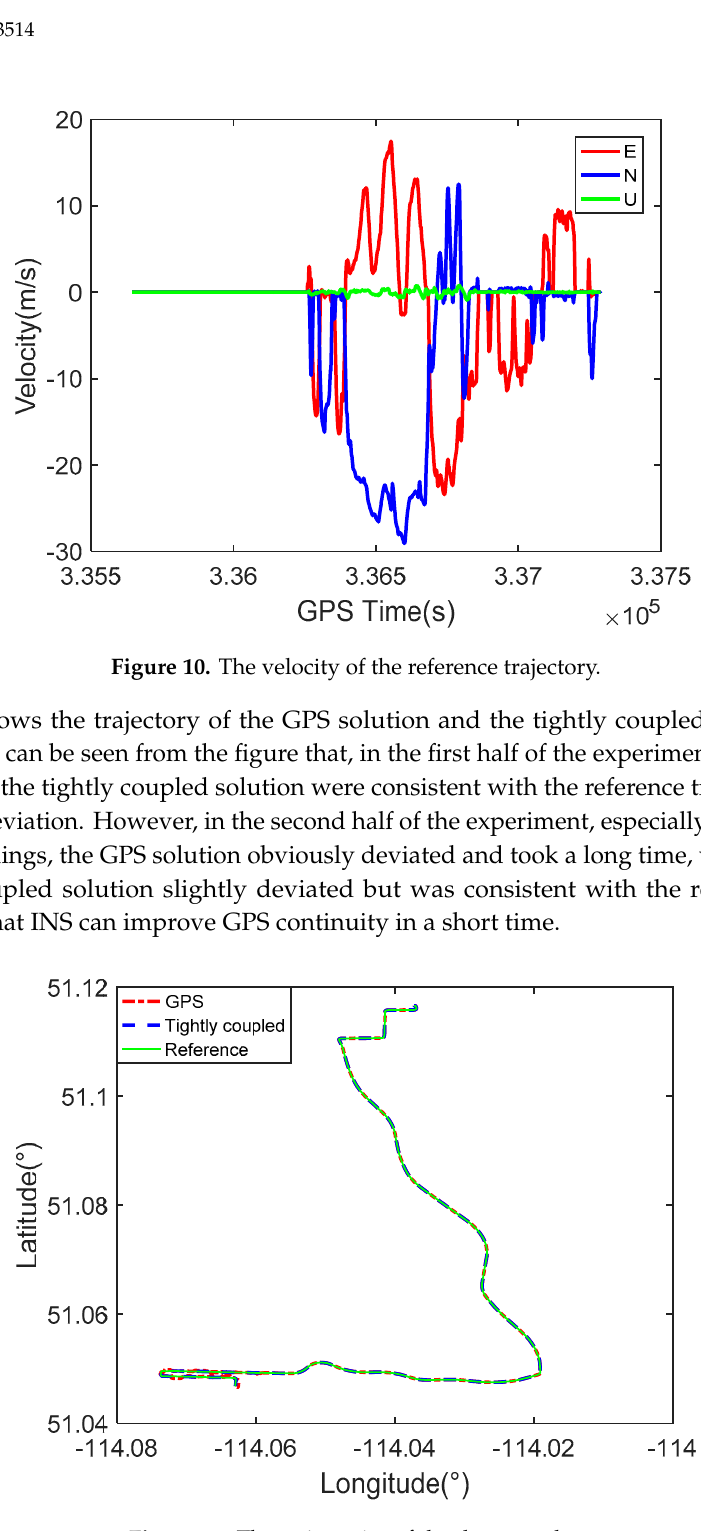
Figure 11. The trajectories of the three results.